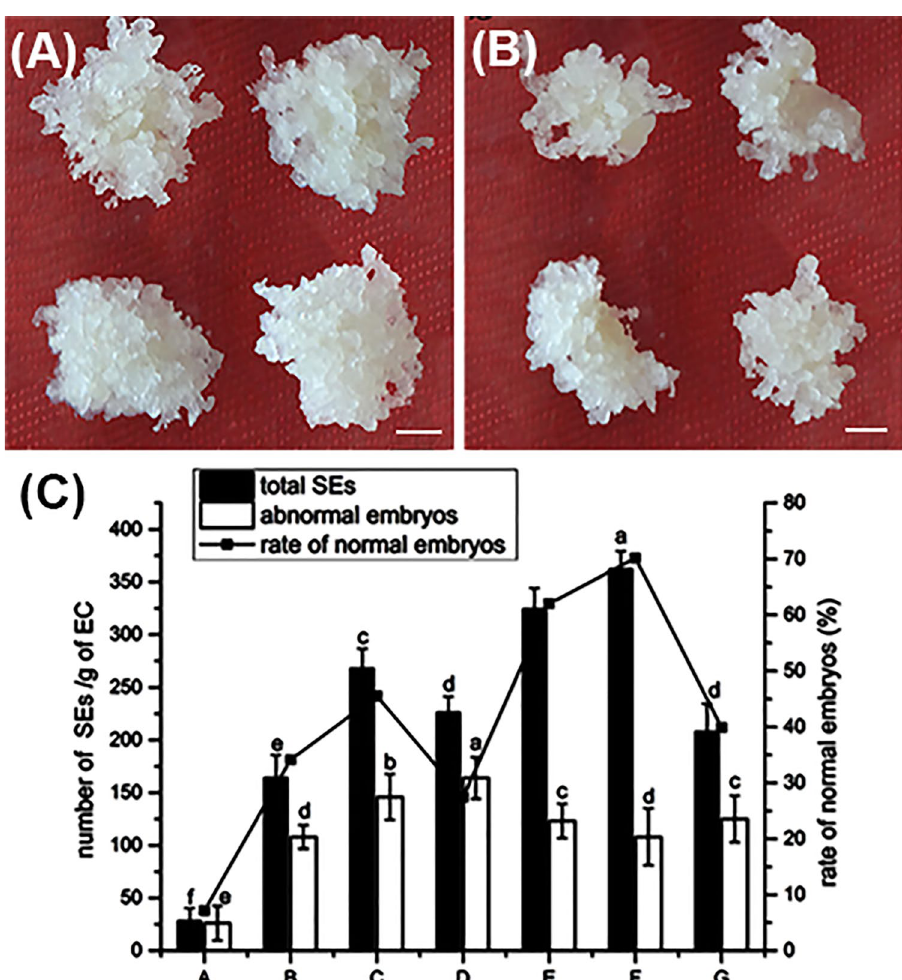
Figure 4. Effect of plant growth regulators on EC proliferation and SEMs maturation. ( A , B ) Effect of 2,4-D on EC proliferation. ( A ) EC proliferation on 1/2 MS medium with 1.6 mg L −1 2,4-D, and the fresh weight grew quickly. ( B ) EC proliferation on 1/2 MS medium with 3.2 mg L −1 2,4-D, and the fresh weight grew slowly. Bars 1 mm. ( C ) Effect of different concentrations of ABA and PEG4000 on SEMs maturation. The X axis represents different concentrations of ABA and PEG4000, A, B, C, and D only add ABA at 7.5 mg L −1 , 15 mg L −1 , 22.5 mg L −1 and 30 mg L −1 respectively, to 1/2 LM media. E, F and G add 22.5 g L −1 , 45 g L −1 , 67.5 g L −1 PEG4000 on 1/2 LM with 22.5 mg L −1 ABA. Bars denoted by the same letter within response variables are not significantly different ( P = 0.05) using Duncan’s multiple range test. The experiment was repeated three times.